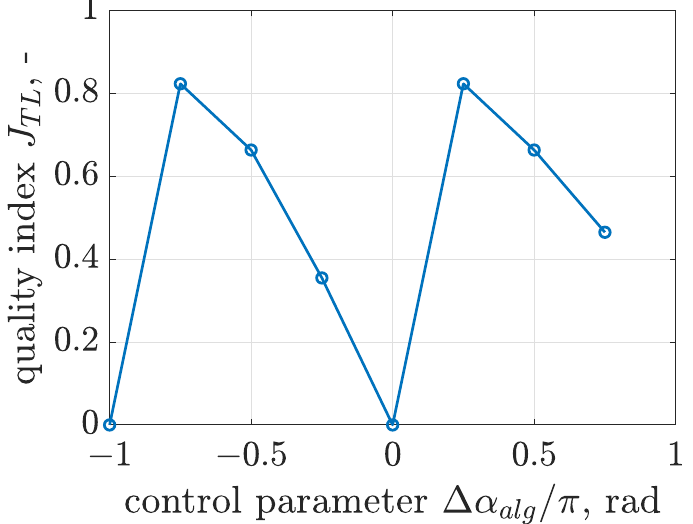
Figure 26. Comparison of values of quality index J TL assessing the linearity the trajectory control algorithm presented for different control parameters ∆ α alg applied to a semi-active screen suspension with the Bouc–Wen